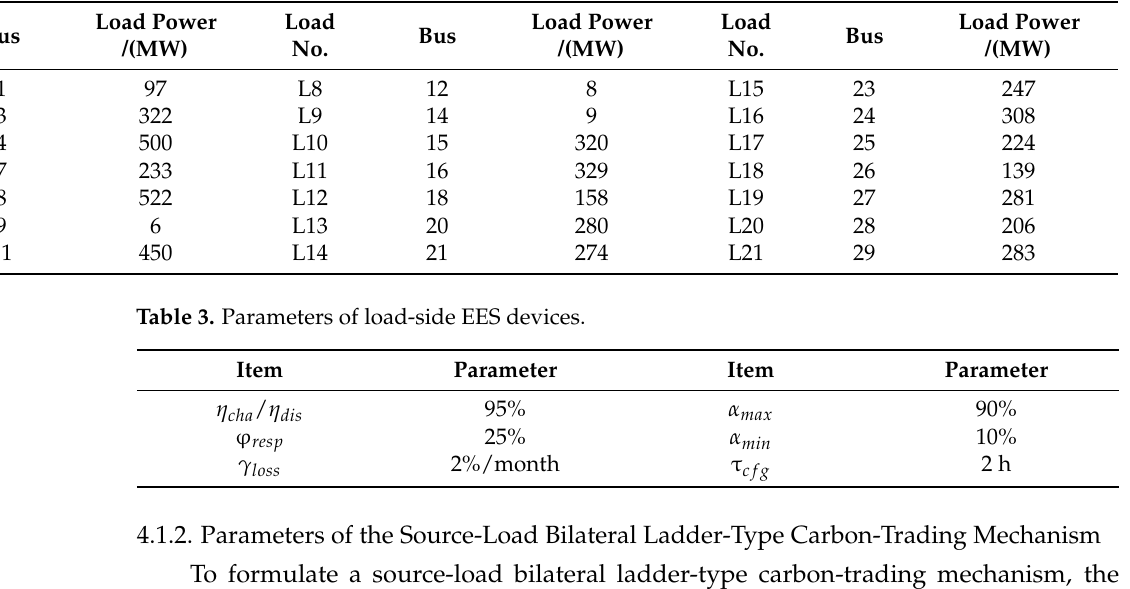
Figure 3. The forecast wind power and load power of a typical day. Table 2. Parameters of loads.